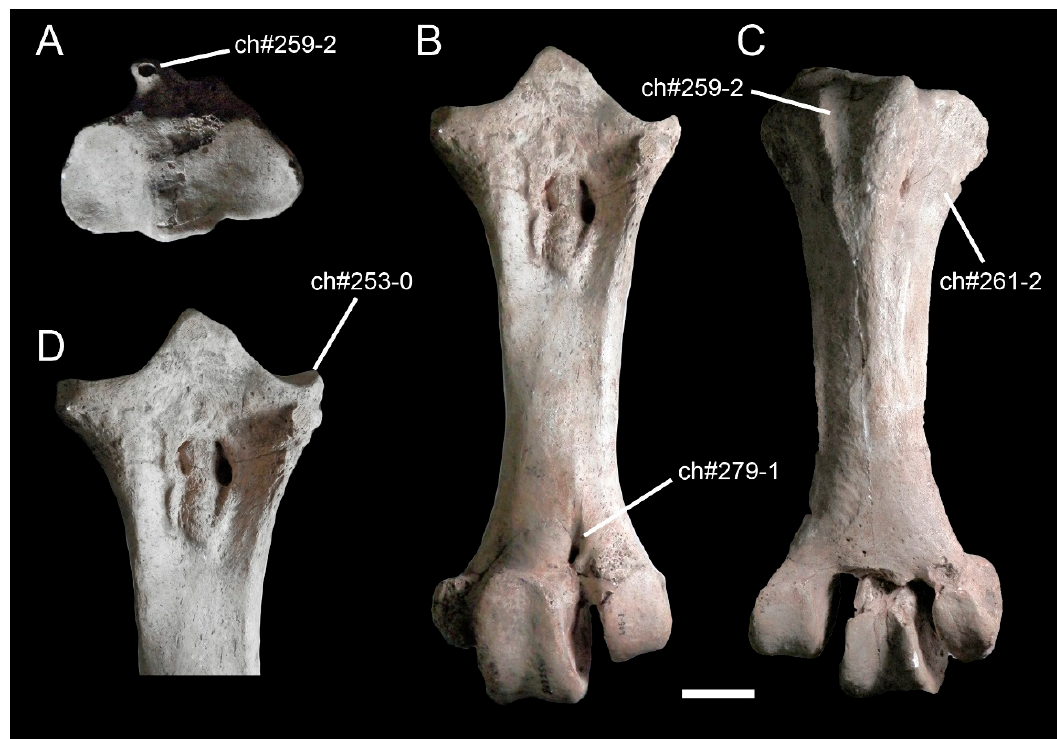
Figure 7. Left tarsometatarsus of Brontornis burmeisteri (plaster copy of FM-P13259) in ( A ) proximal, ( B ) anterior, and ( C ) posterior views. ( D ) detail of the proximal region of the tarsometatarsus in anterior view. The notation includes the characters that were modified from Worthy et al. [24]. ch#253-0, plantar-lateral side of cotyla medialis elevated proximally; ch#259-2, hypotarsus with two ridges; ch#261-2, surface from medial calcaneal ridge to anterior margin of medial shaft concave (shallow fossa parahypotarsalis medialis); and ch#279-1, foramen vasculare distale small and distinct. Scale bar for A to C: 4 cm; D, 3.5 cm.